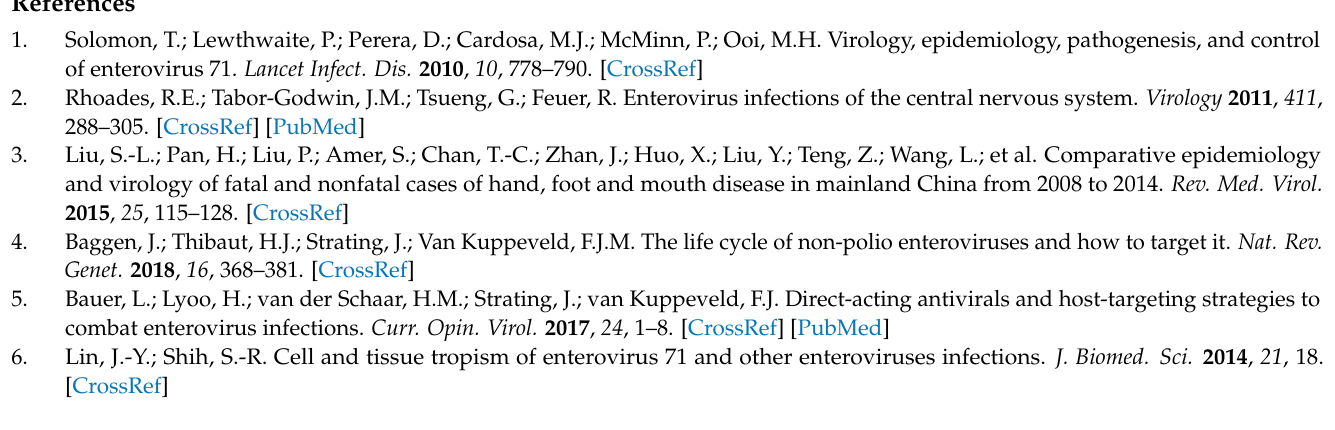
Figure S1: Chemical structures of sertraline, fluvoxamine and paroxetine in Supplementary Section S1; Supplementary Website: The expression profiles of the serotonin transporter encoded by the SLC6A4 gene in various tissues and cell lines in Supplementary Section